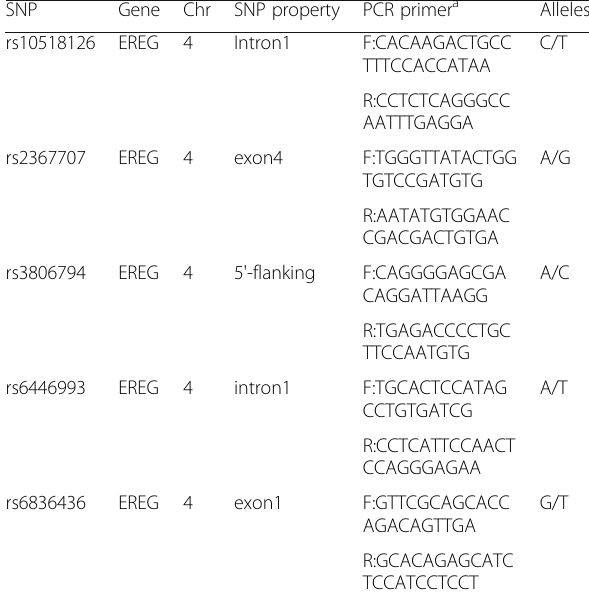
Table 2 Single nucleotide polymorphisms (SNPs) of EREG gene SNP Gene Chr SNP property PCR primer